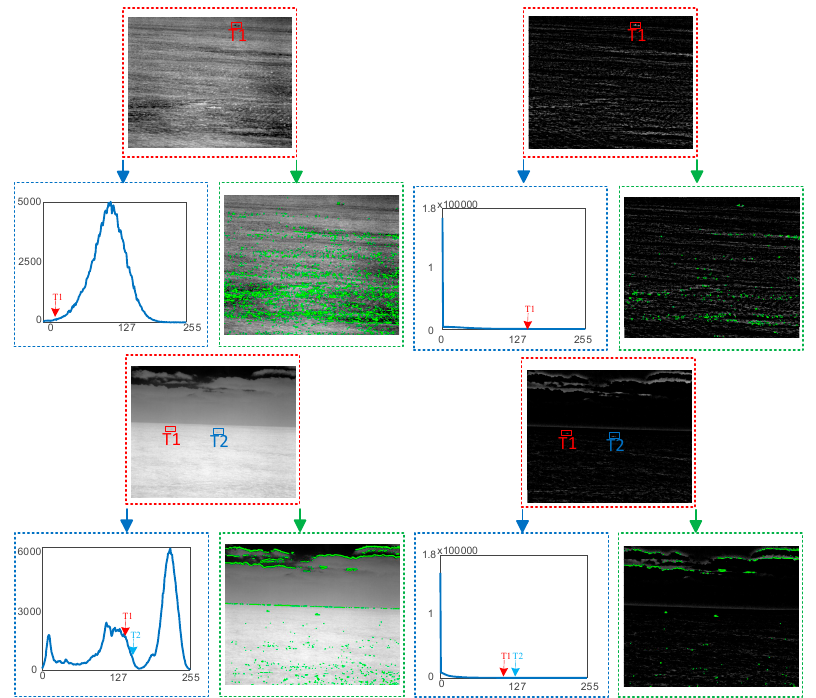
Figure 4. Global gray histogram and local contrast of typical original image and background suppression